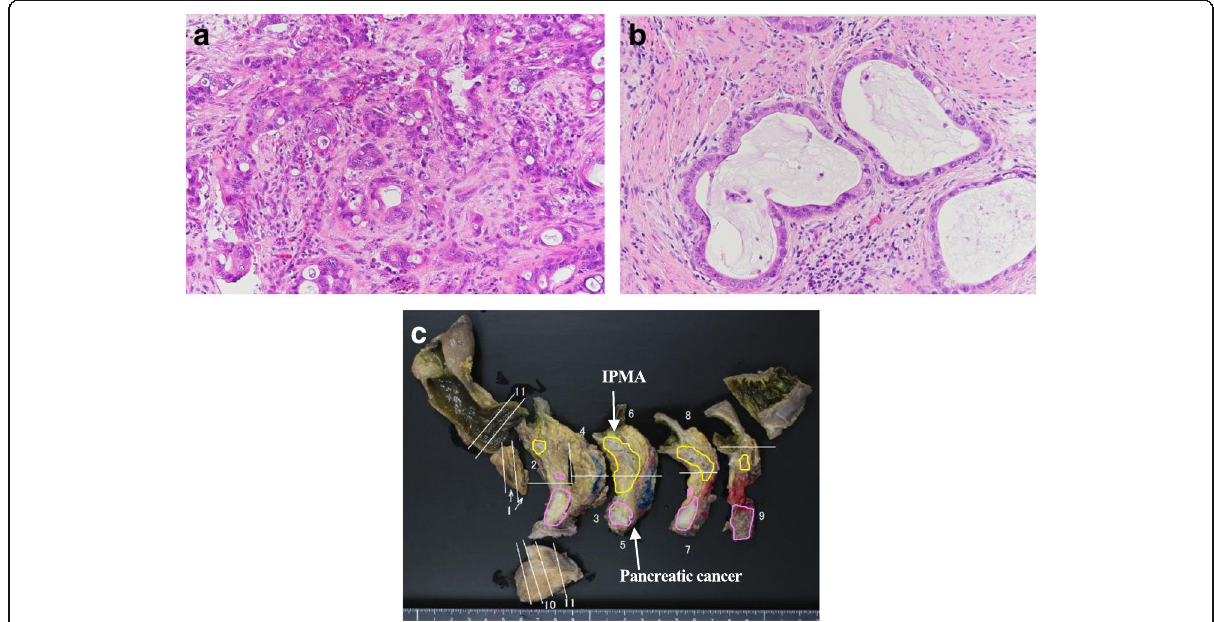
Fig. 3 Histological examination. a Moderately differentiated ductal adenocarcinoma of the pancreas. b Well-differentiated tubular adenocarcinoma of the gallbladder. c There was no continuity in histopathological examination between pancreatic cancer and